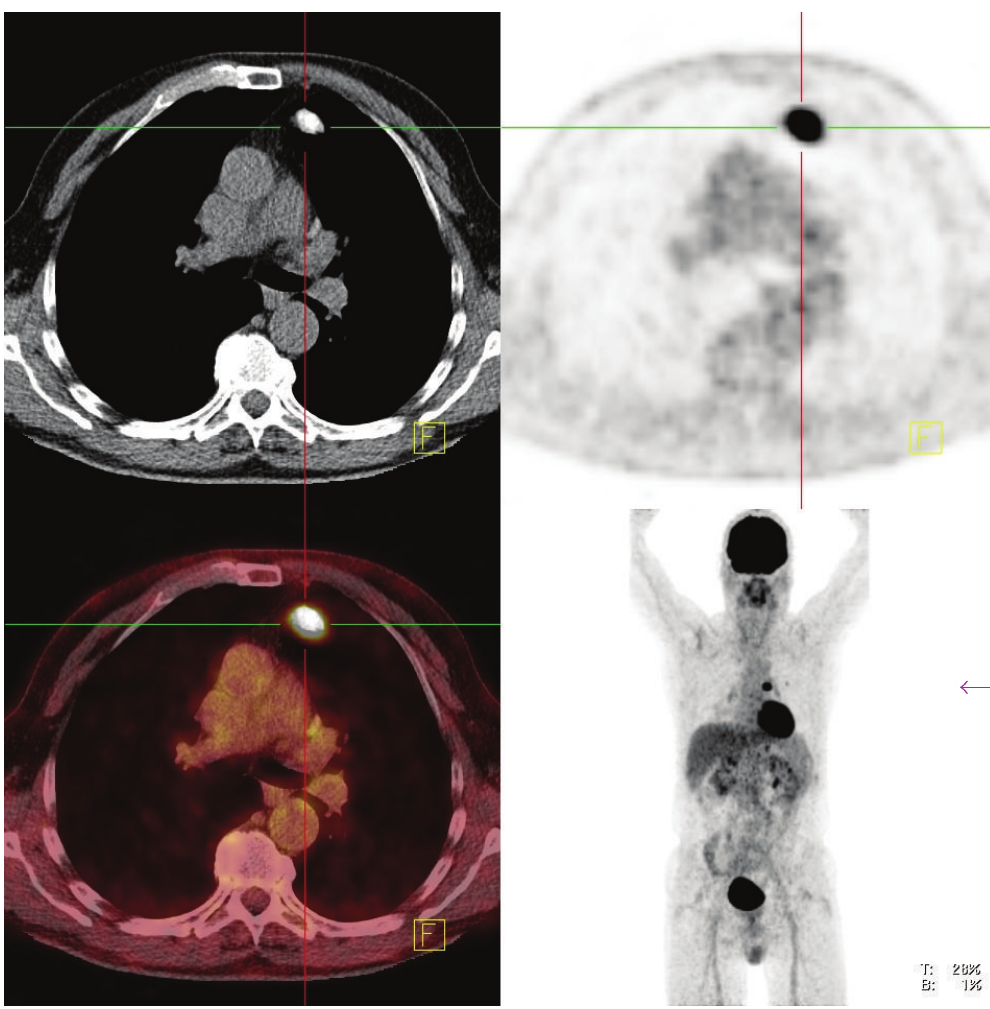
Figure 1: Pulmonary nodule with high FDG uptake ventrally in the left upper